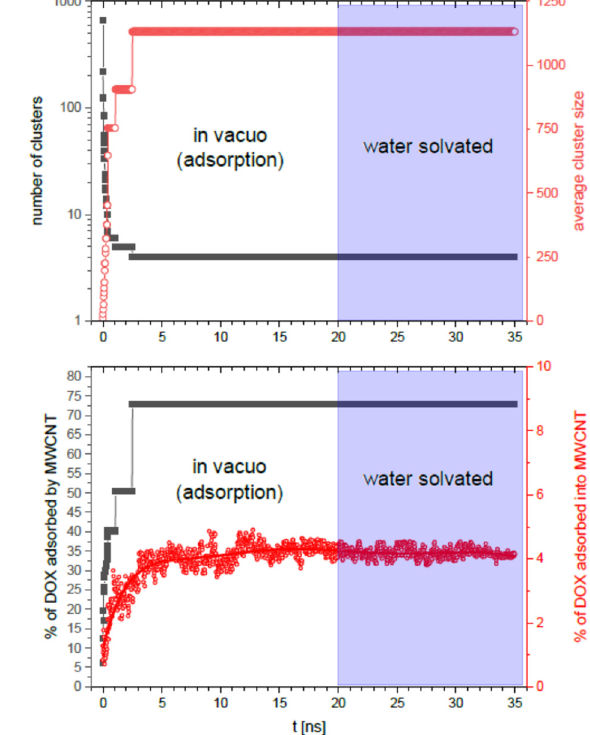
Figure 10. Results of molecular dynamics simulation of MWCNTs + DOX system. Selected parame- ters as a function of time, t , during the adsorption process in vacuo (from t = 0 to t = 20 ns) followed by the simulation of the system in solution with water (from t = 20 ns to t = 35 ns): ( a ) number of aggregates (grey squares) and average aggregate size (red circles); ( b ) total percentage of DOX molecules adsorbed by MWCNTs (grey squares) and percentage of DOX molecules adsorbed inside MWCNTs (red circles).